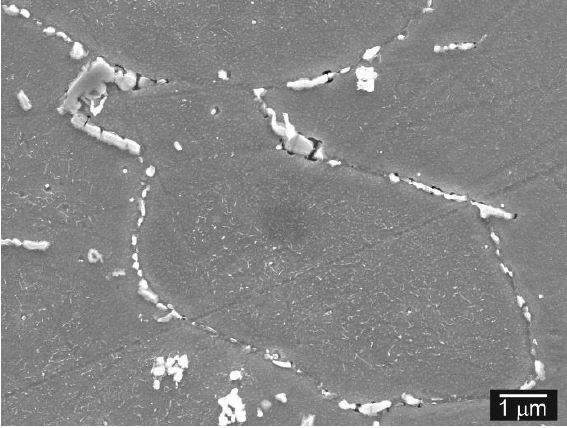
Figure 15. SEM micrograph of Ni WM—detailed view on detached and/or cracked NbC precipitates at grain boundaries.